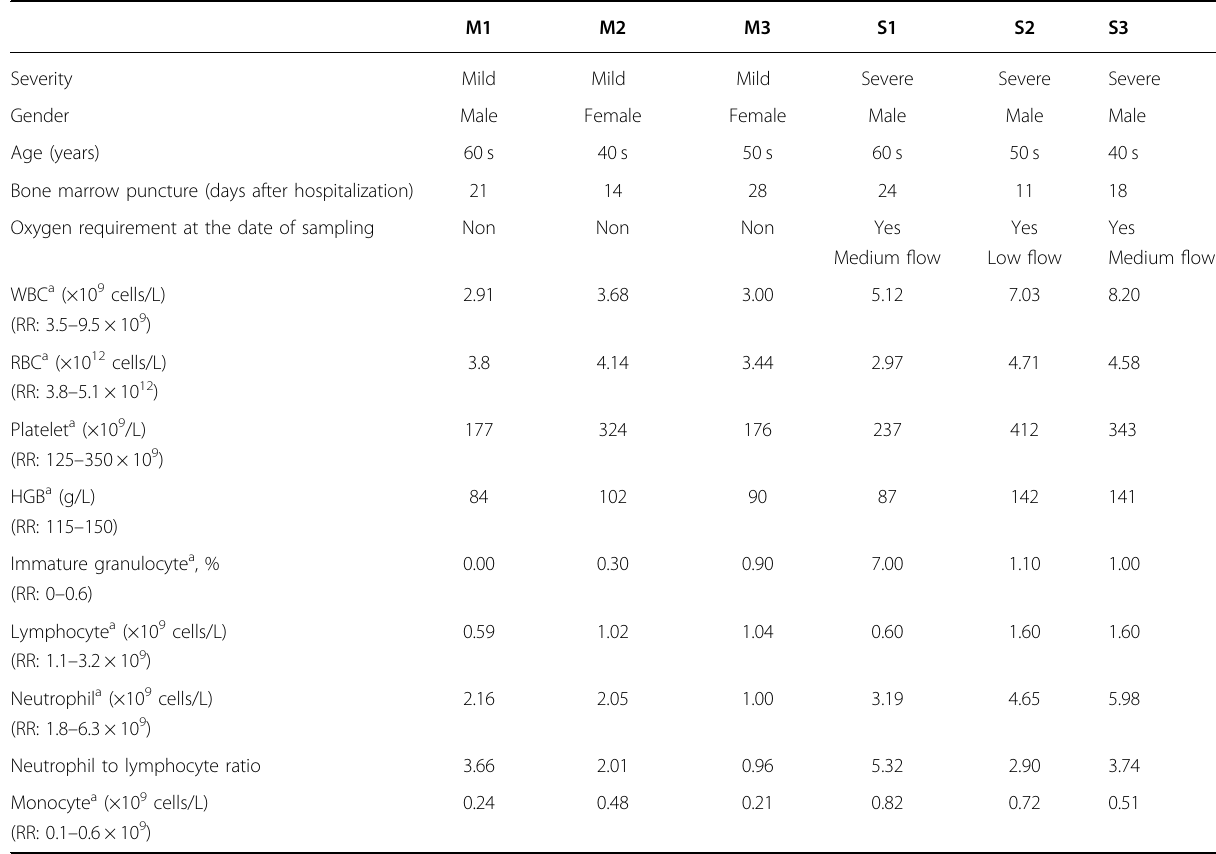
Table 1 Clinical data of the enrolled patients.